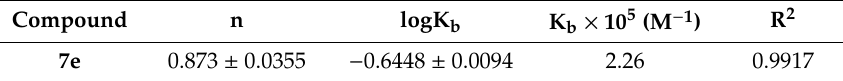
Table 7. Binding constant and binding sites for compound 7e binding into